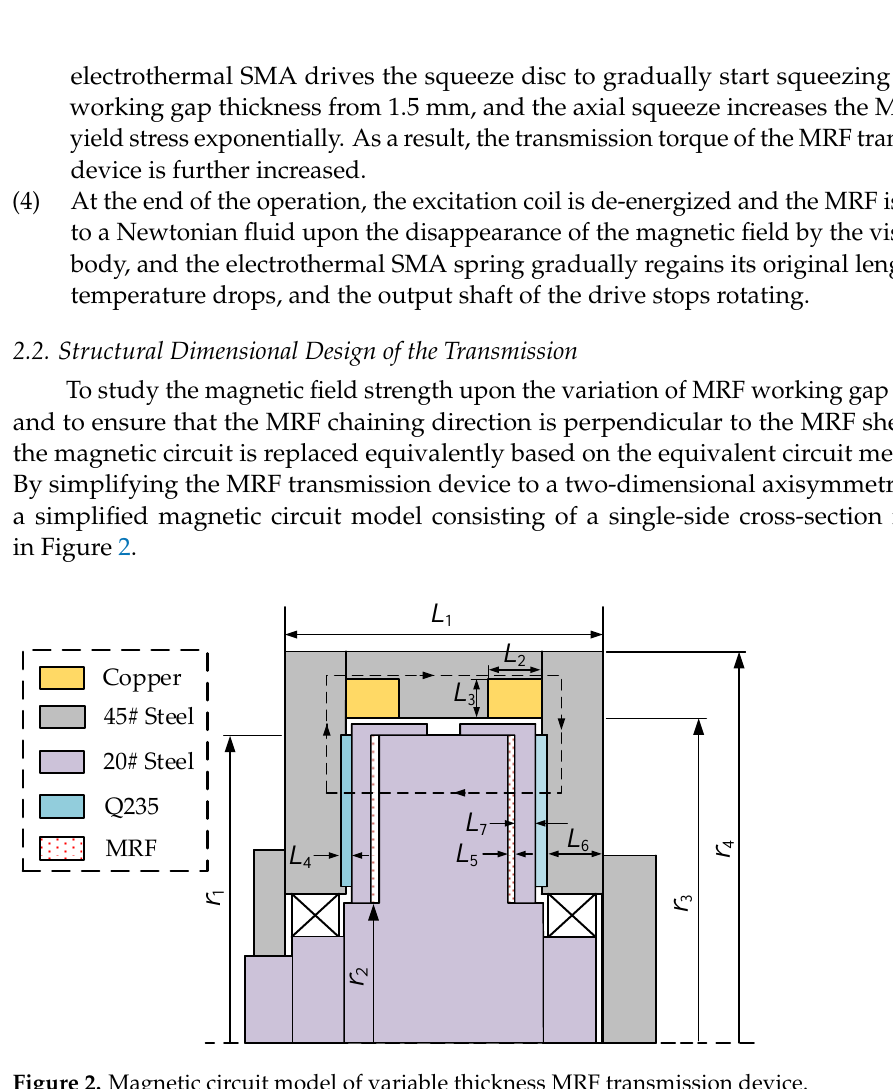
Table 1. Structural parameters of the transmission